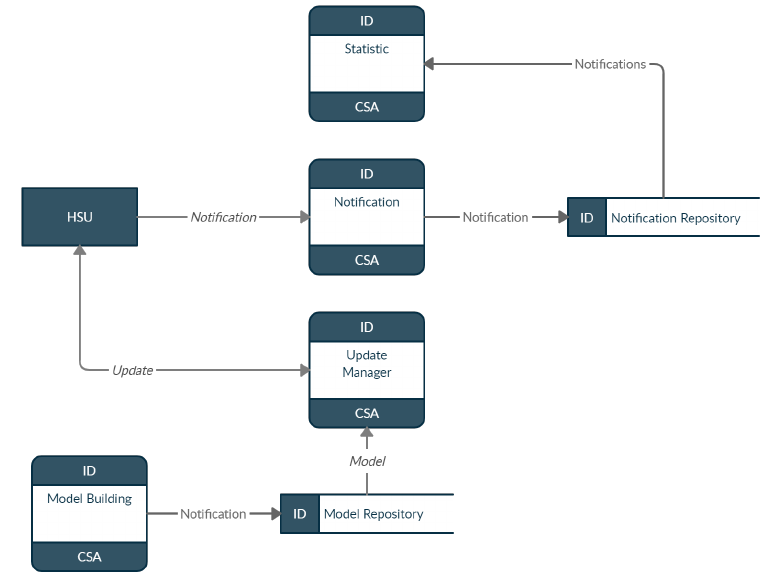
Figure 5. Communication between CSA